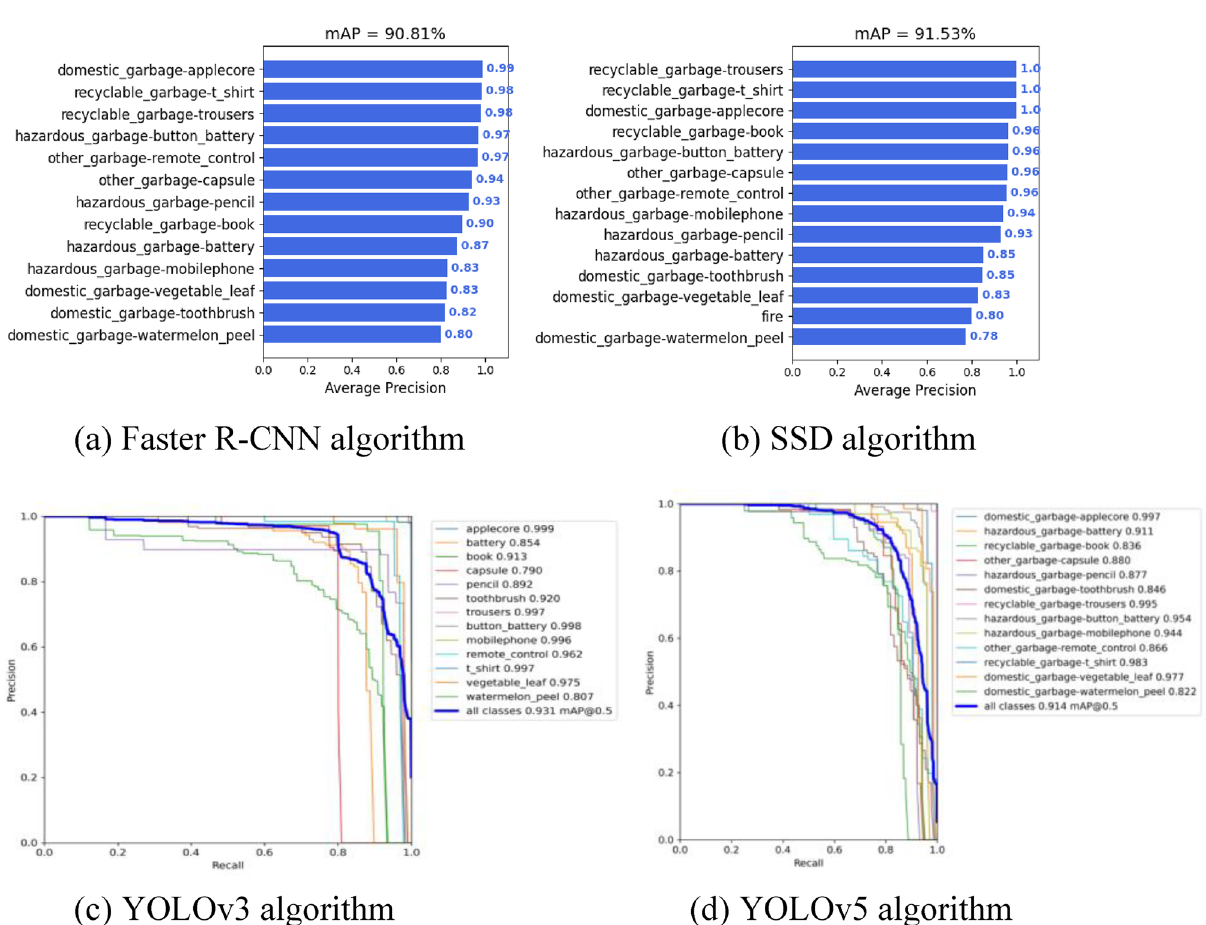
Figure 17. The mAP training results of the four detection algorithms.